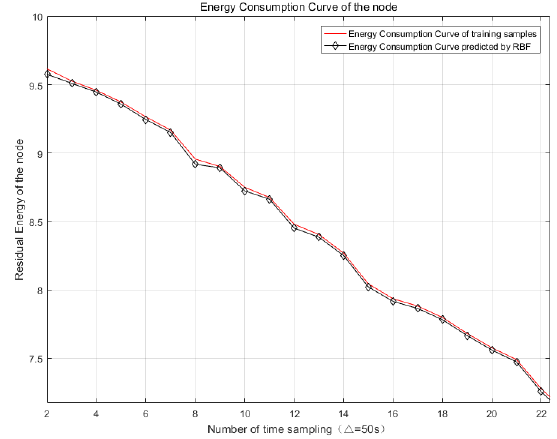
Figure 5. The dynamic energy consumption rate curve predicted by RBF.